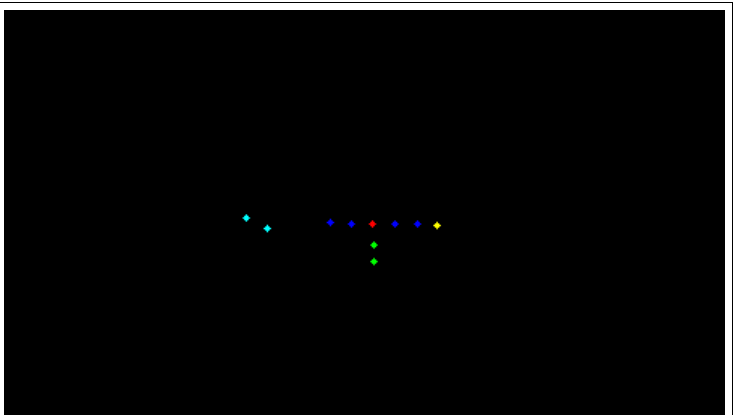
Figure 7. processed data for formation identification module—the locations of the players are represented with the pixel coordinate locations of the marks, and the labels of the players are represented by the colors of the